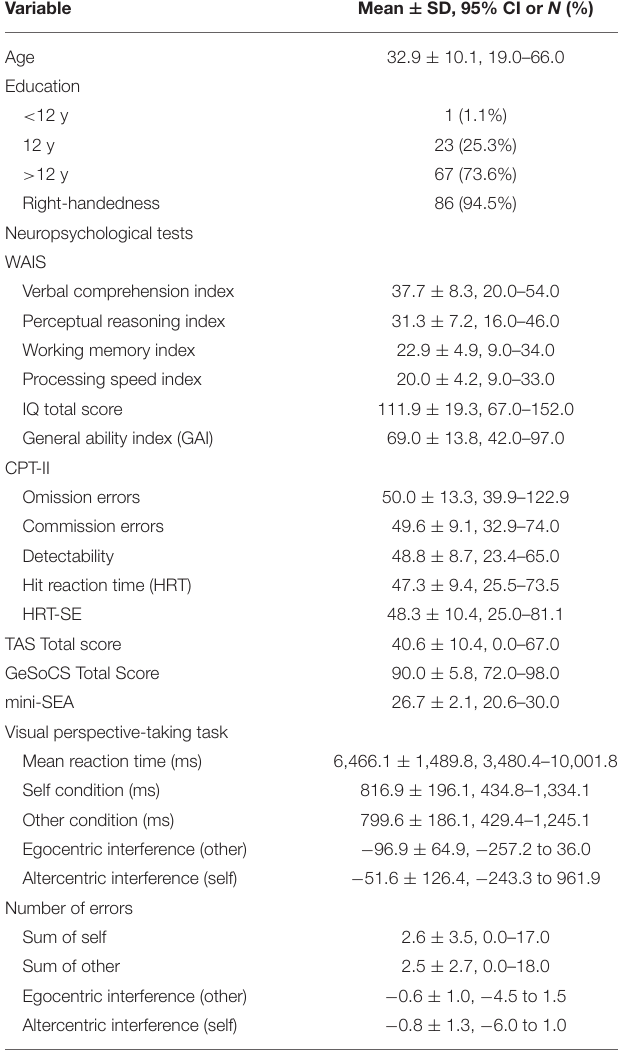
TABLE 1 | Participant’s characteristics ( N =